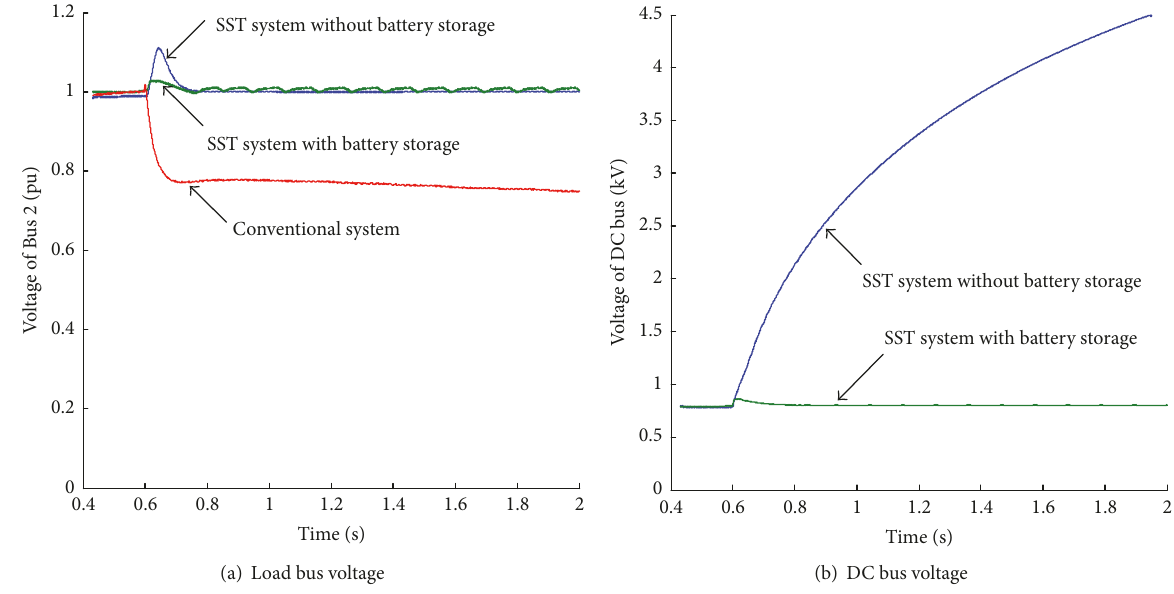
Figure 8: Response curves when disconnection fault occurs at the midpoint of Line